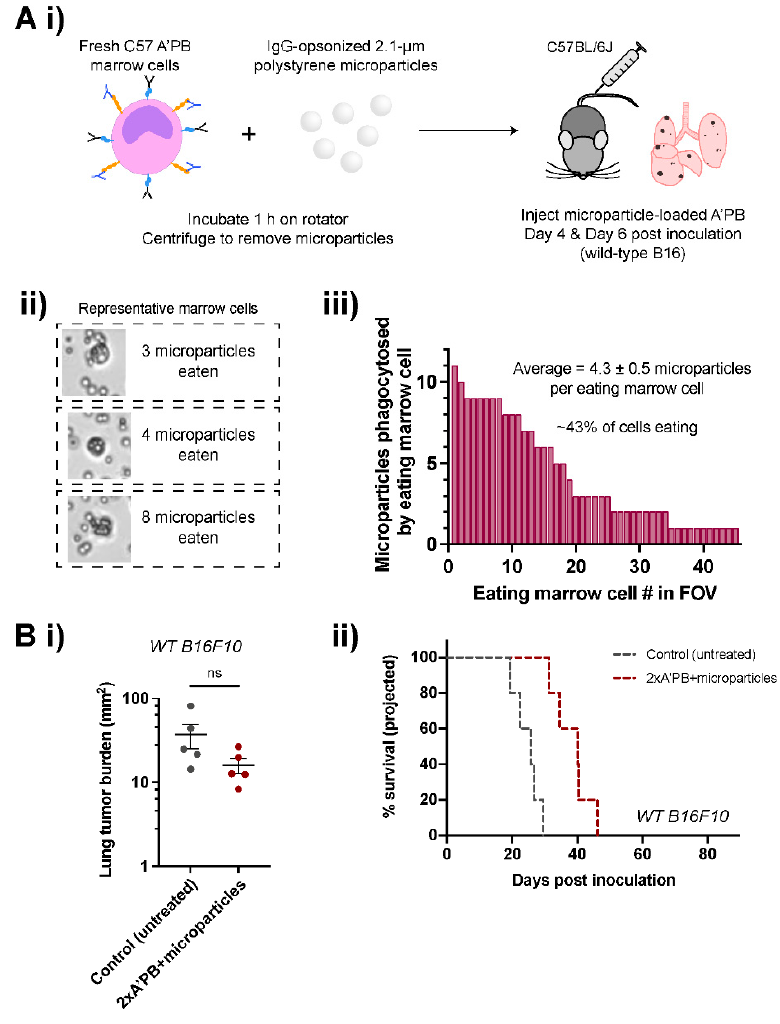
Figure 7. Pre-loading A’PB with microparticle cargo hinders tumor suppression. ( A ) Antibody-engineered macrophages/monocytes pre-loaded with cargo prior to treatment. (i) Schematic of in vivo marrow pre-load therapy to assess off-target effects on phagocytosis. Freshly harvested marrow cells phagocytose IgG-opsonized polystyrene microparticles for 1 h prior to tail-vein injections. (ii) Representative images of marrow cells with polystyrene microparticles, with excess particles removed by centrifugation prior to injection. (iii) Quantification of microparticles engulfed per marrow cell in a field of view (FOV). About 40% of marrow cells engulfed up to ~10 particles. ( B ) In vivo phagocytosis of WT B16F10 cells in A’PB marrow treatments. (i) Lung tumor burdens in control (untreated) and 2 × A’PB + microparticle pre-loaded groups. Mice were treated with antibody-engineered marrow on days 4 and 6 in addition to tail-vein injections of 250 µ g anti-Tyrp1 per Figure 2B through day 13. Mean and s.e.m. (n.s. not significant, Ordinary one-way ANOVA with Dunnett’s multiple comparisons, n = 5 per three groups, including 2 × A’PB in Figure 5B). (ii) Projected survival